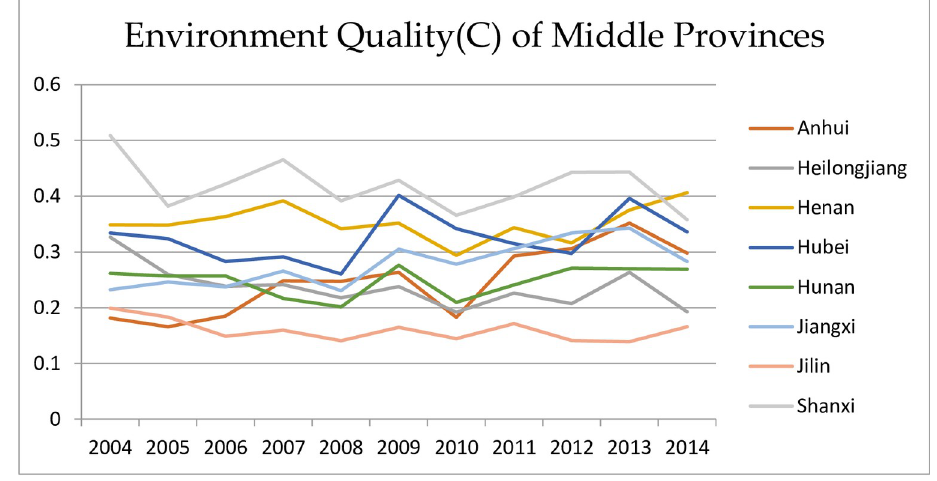
Fig 3. Environment quality (C) of Middle